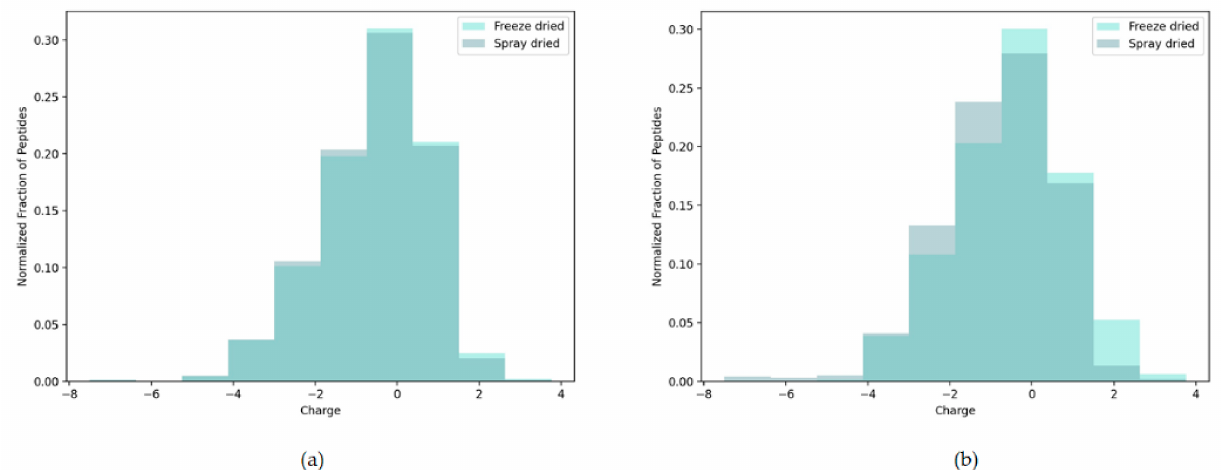
Figure 4. Peptide distribution according to charge in FD and SD samples of rice NPN. The peptide profile as determined by LC-MS/MS in a histogram representation of rice NPN samples; peptide distribution is according to charge in ( a ) peptides present in full samples or ( b ) peptides exclusive in either FD (teal bar) or SD (blue bar) samples. All data is normalised for count.